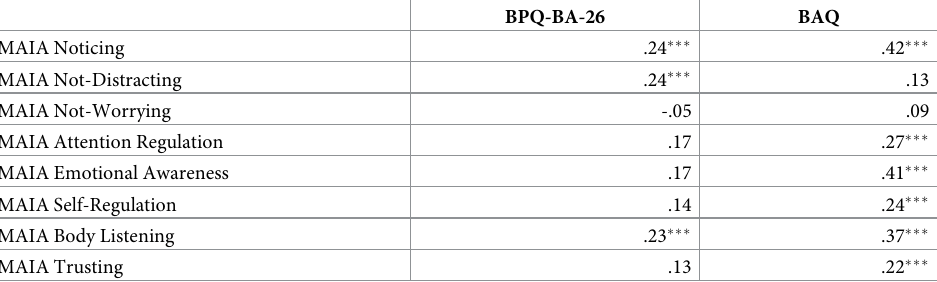
Table 2. Spearman correlations between the assessed measures of ISb (the association between BPQ-BA-26 and BAQ is r s = .27, p <